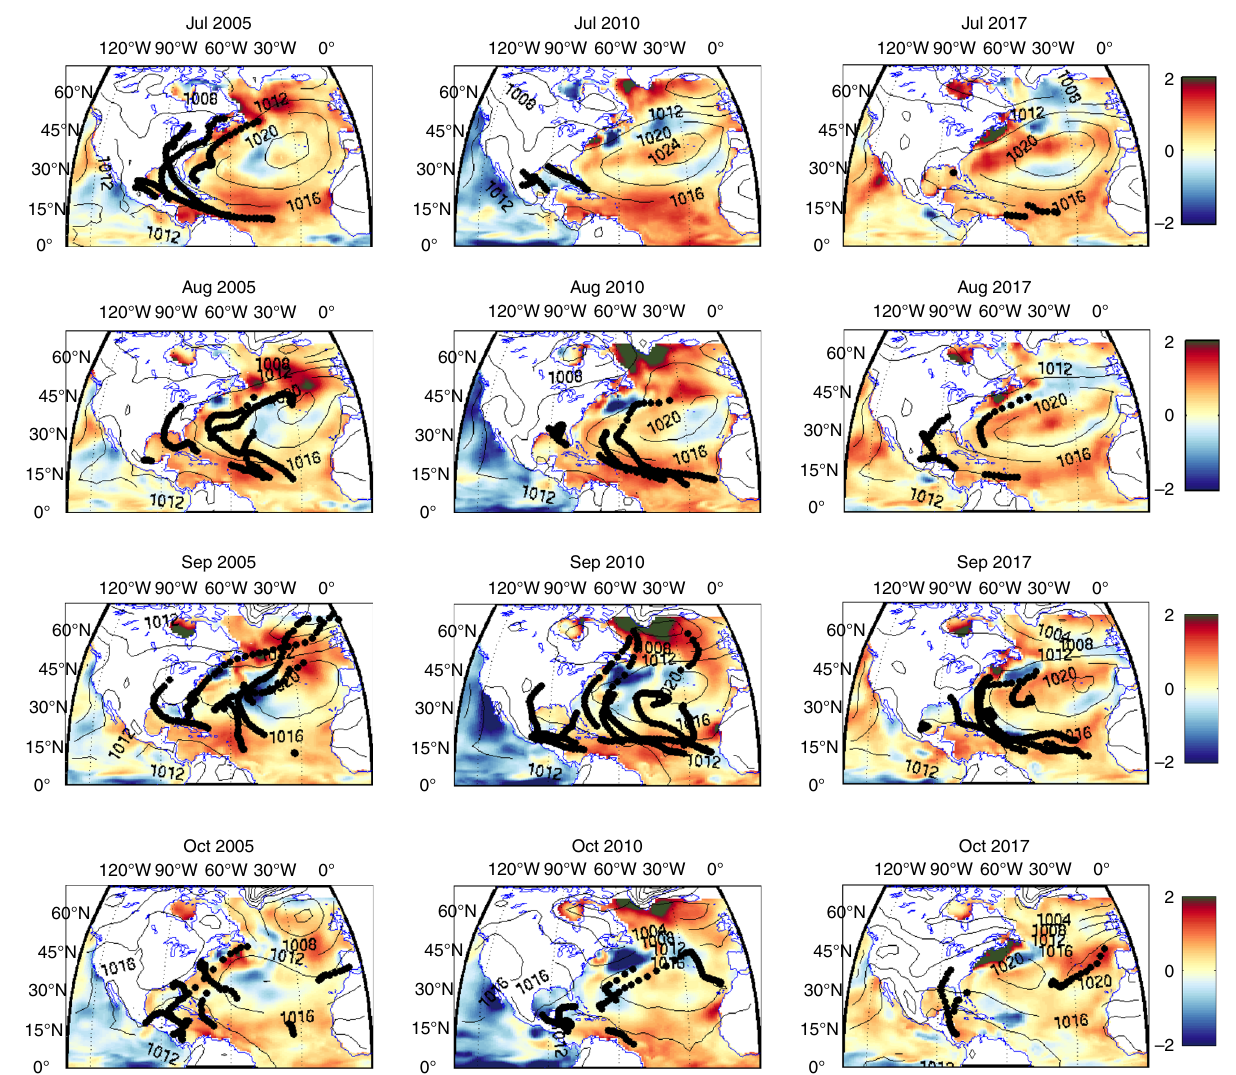
Fig. 2 Atlantic tropical cyclone tracks during July, August, September and October for 2005, 2010 and 2017. Tropical cyclone tracks (black) and observed SSTA (colour, °C) overlaid with SLP (contours,